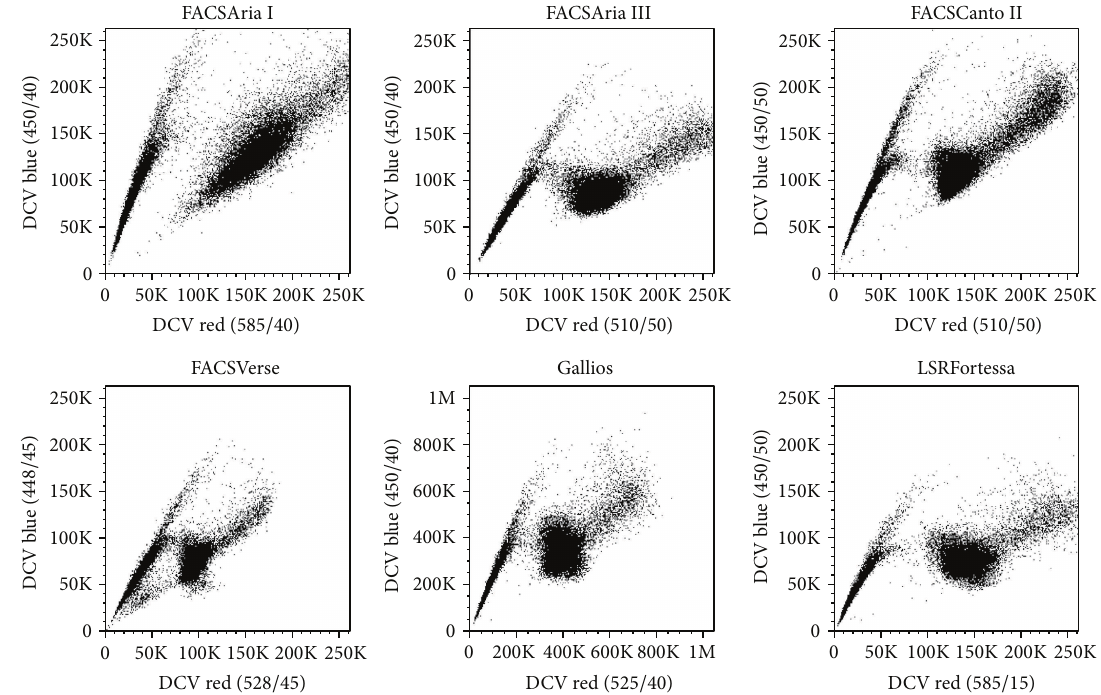
Figure 7: Detection of DCV-SP cells using various flow cytometric instruments. A2780V cells were stained with 10 𝜇 M DCV (10 6